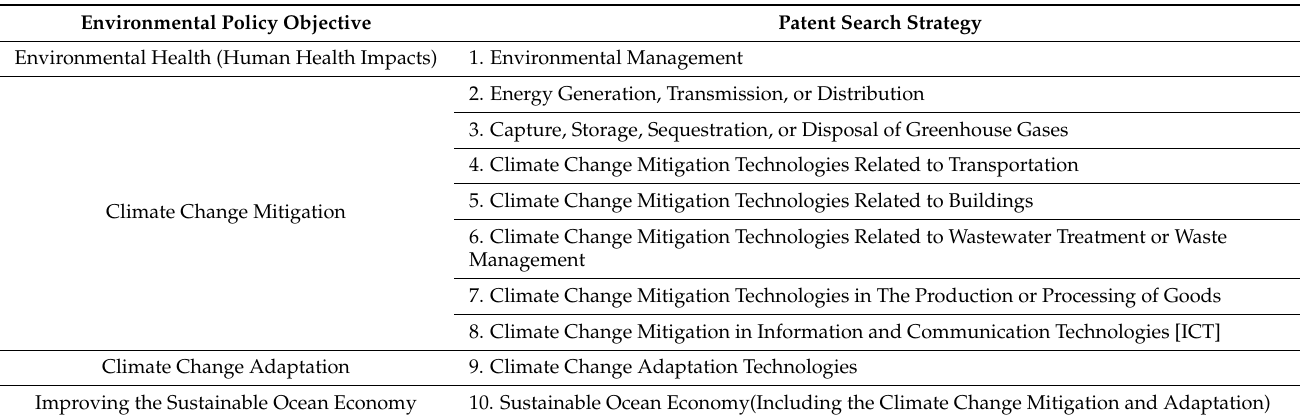
Table 1. OECD ENV-TECH Search Strategies 2020.